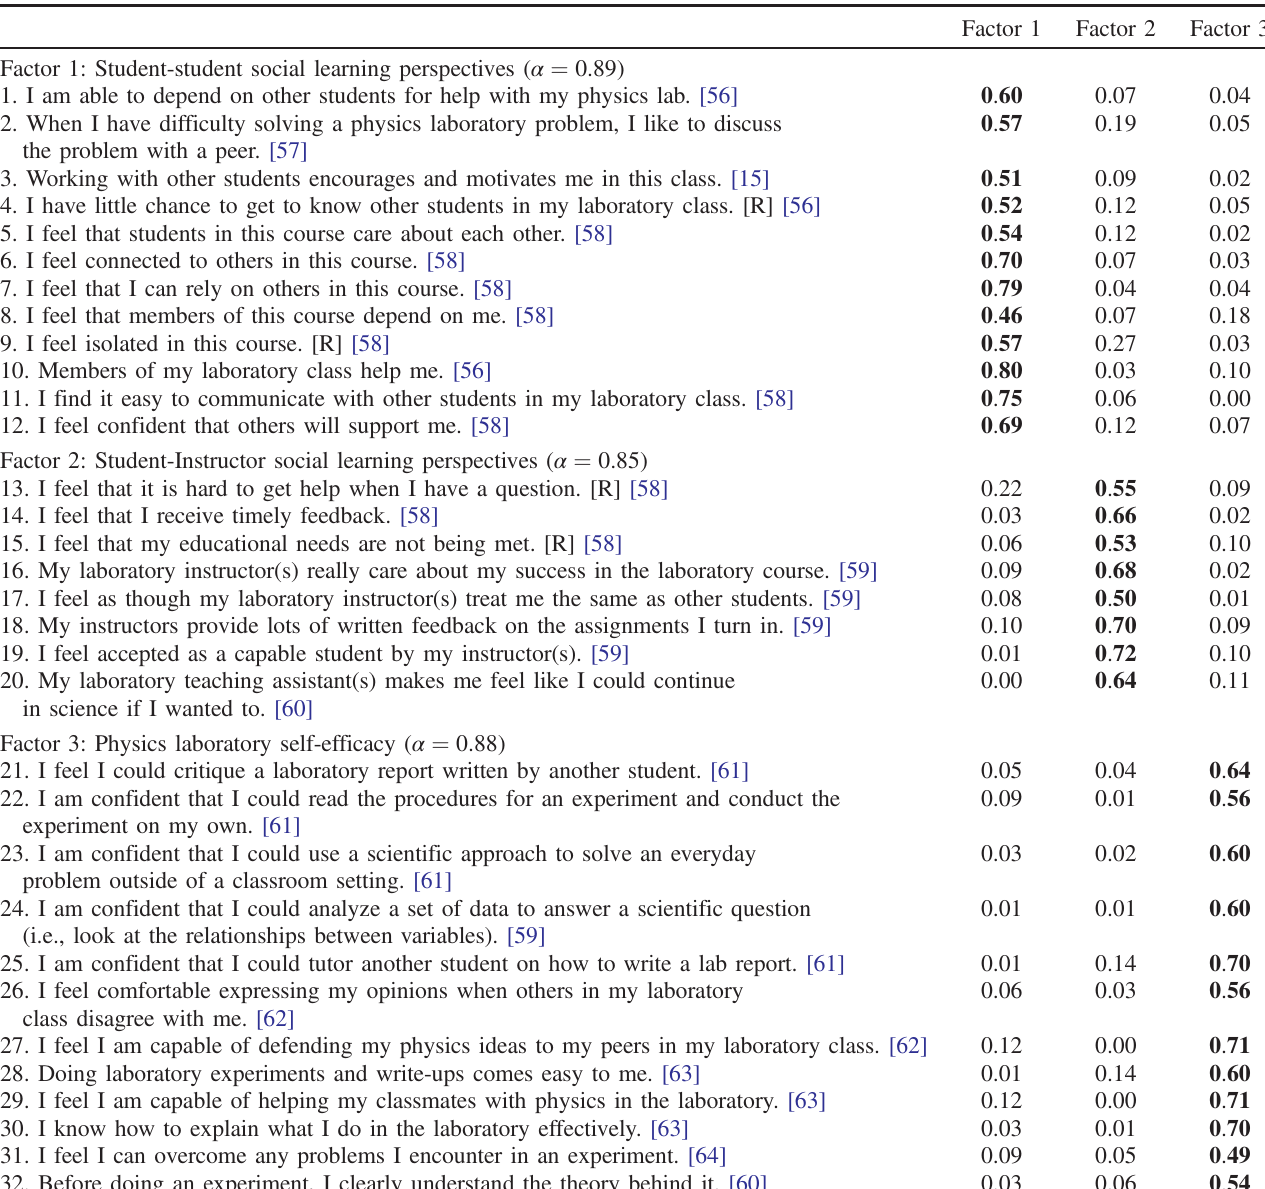
TABLE I. Survey of undergraduate physics social learning perspectives and physics laboratory self-efficacy. Absolute values of factor loadings above 0.30 are